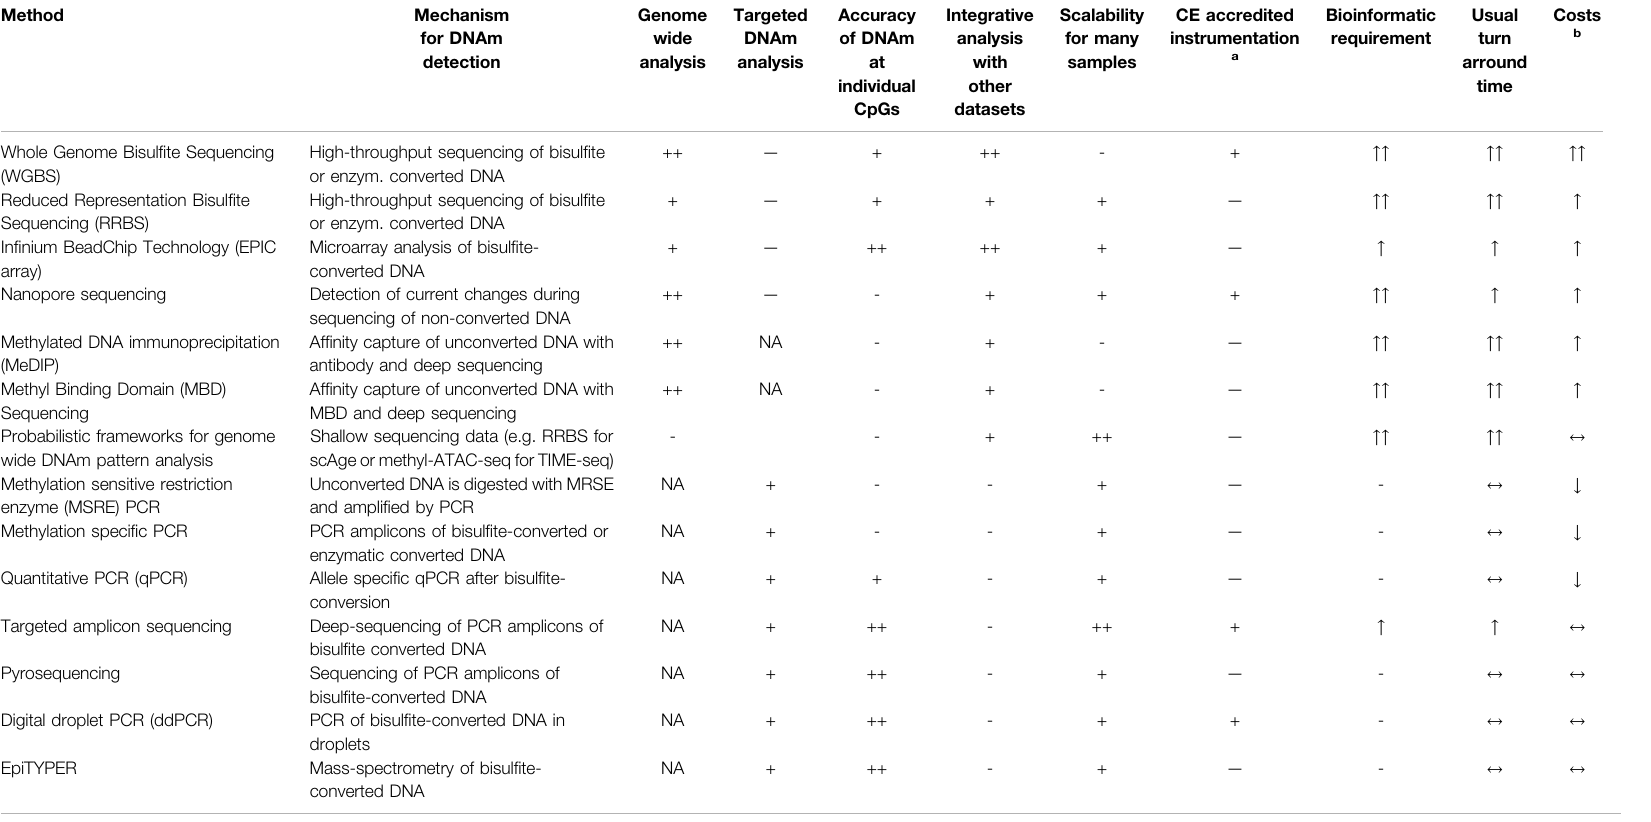
TABLE 1 | Comparison of selected methods for DNAm